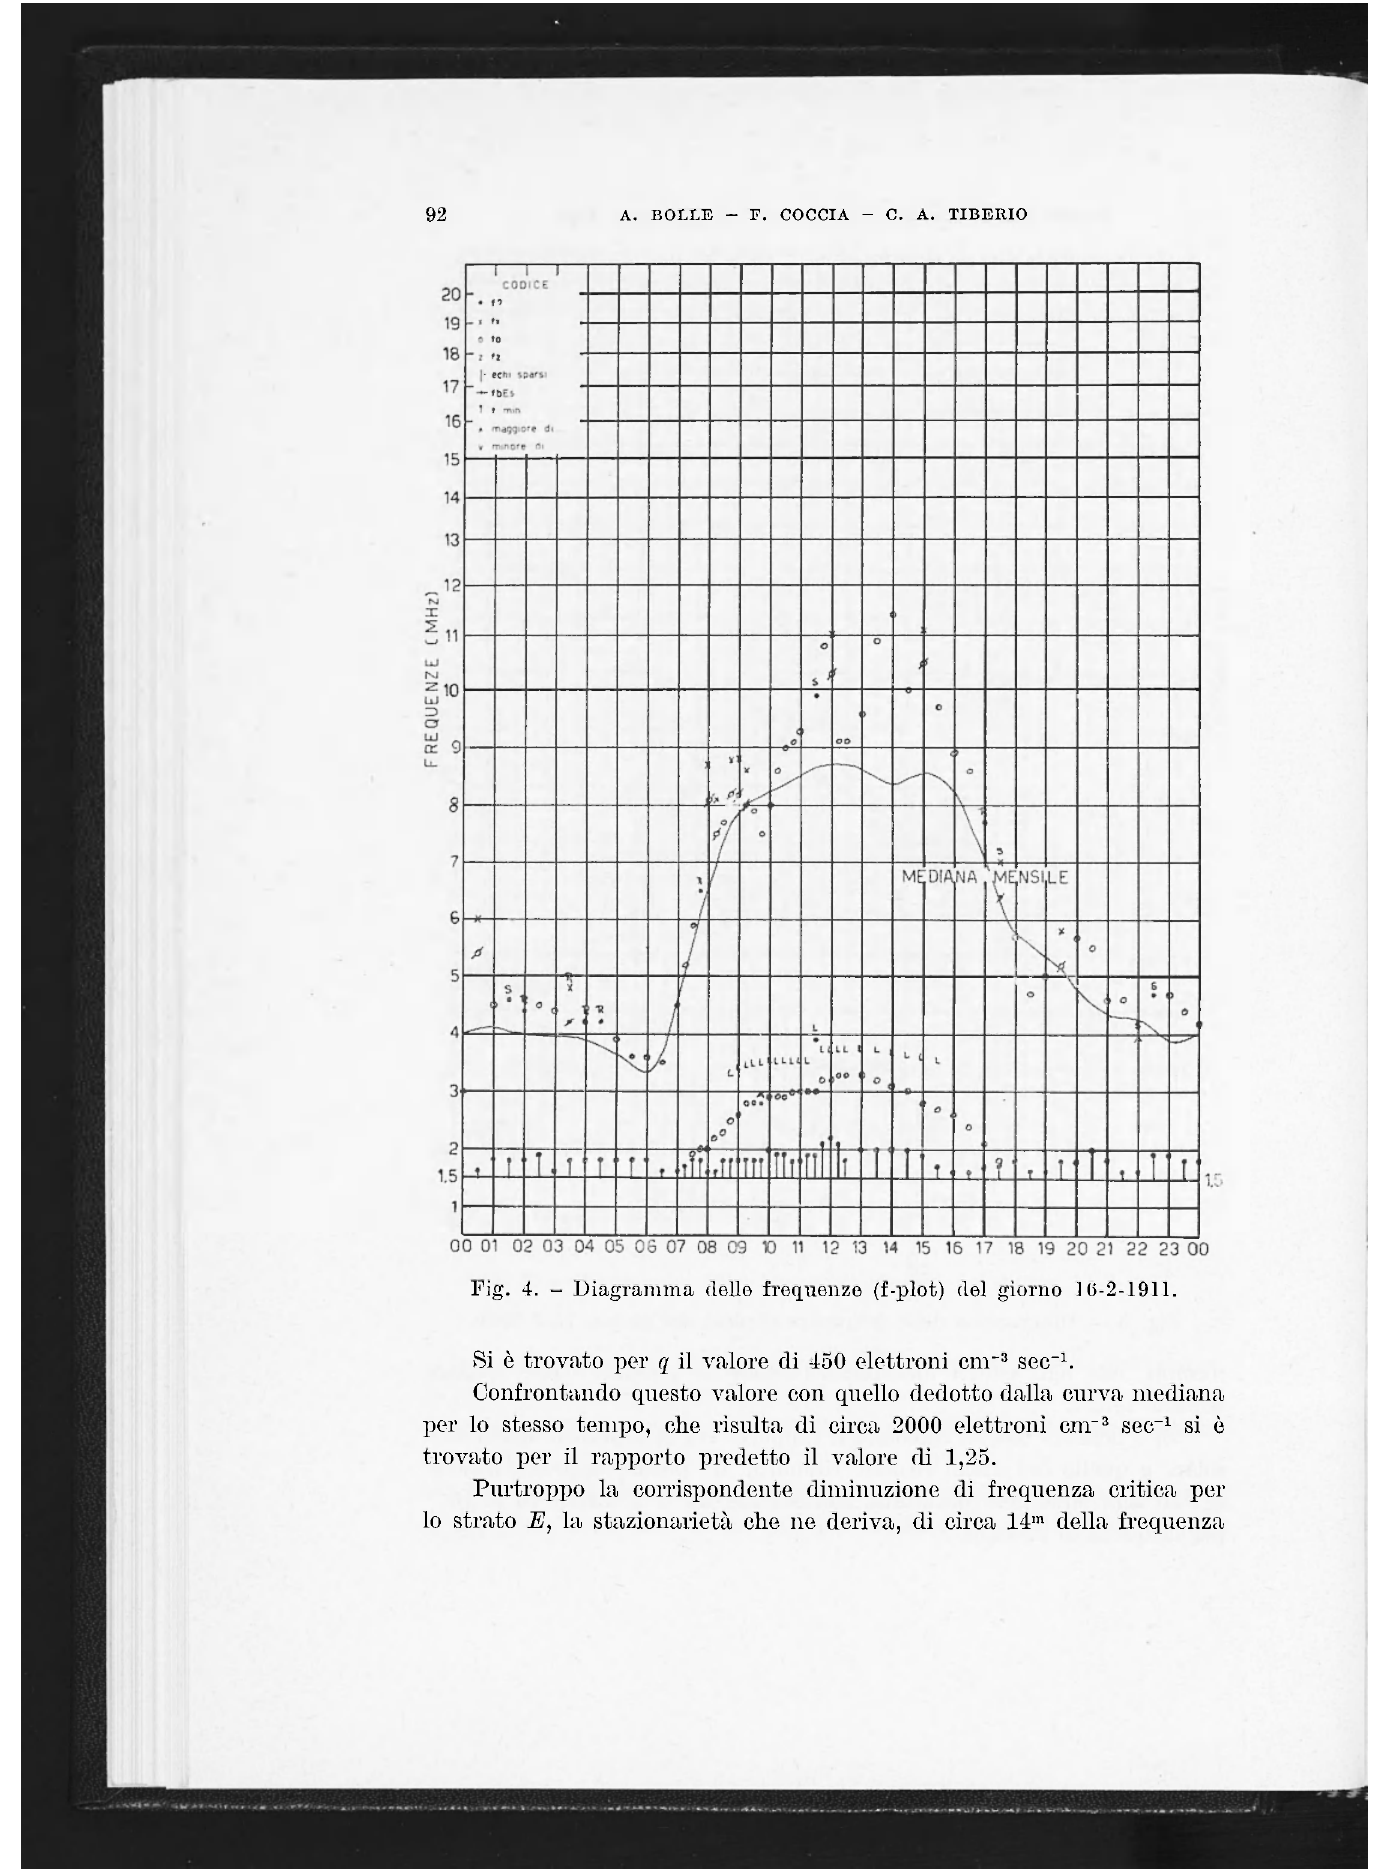
Fig. 4. - Diagramma delle frequenze (f-plot) del giorno 1(5-2-1911. Si è trovato per q il valore di 450 elettroni cnr s sec -1